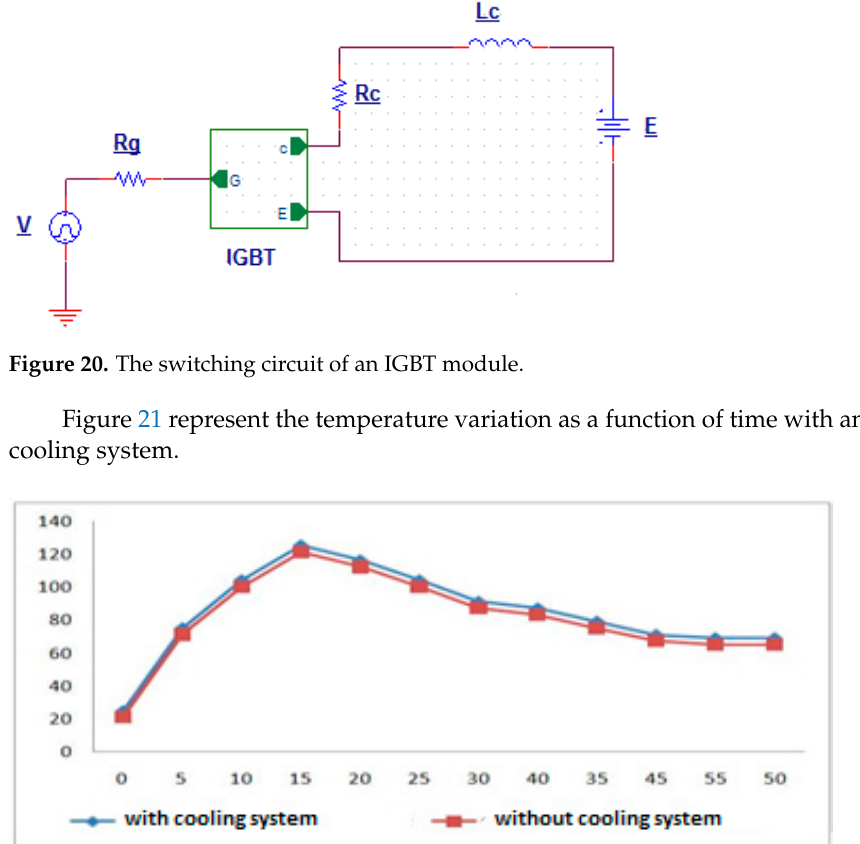
Figure 21. Temperature variation as a function of time with and without a cooling system .